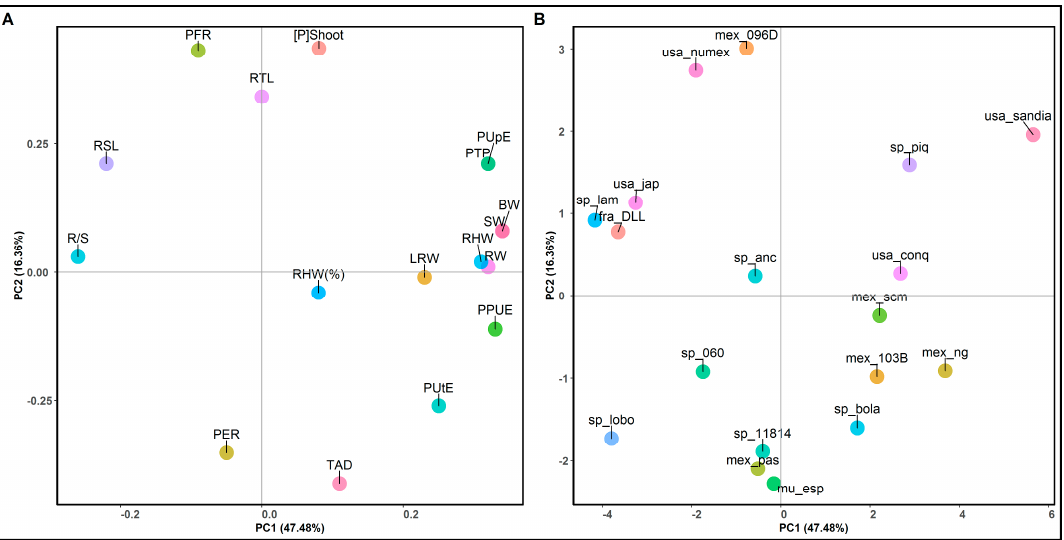
Figure 5. PCA based on trait increments between treatments for the Trial 2 experiment. ( A ) Correlation between traits and the first two principal components. ( B ) Distribution of accessions based on the studied traits. P tissue concentration traits [P] Shoot , P total plant content (PTP) trait, e ffi ciency parameters PPUE (physiological P use e ffi ciency), PER (P e ffi ciency ratio), PUpE (P uptake e ffi ciency) and PUtE (P utilization e ffi ciency) and morphometric traits RW (root dry weight), LRW (lateral root dry weight), RHW (root hairs dry weight), SW (shoot dry weight), BW (total biomass dry weight), R / S (root to shoot ratio), RTL (root total length), TAD (root total average diameter), RHW% (root hairs dry weight %), PFR (proportion of length dedicated to fine roots) and RSL (root specific length) were